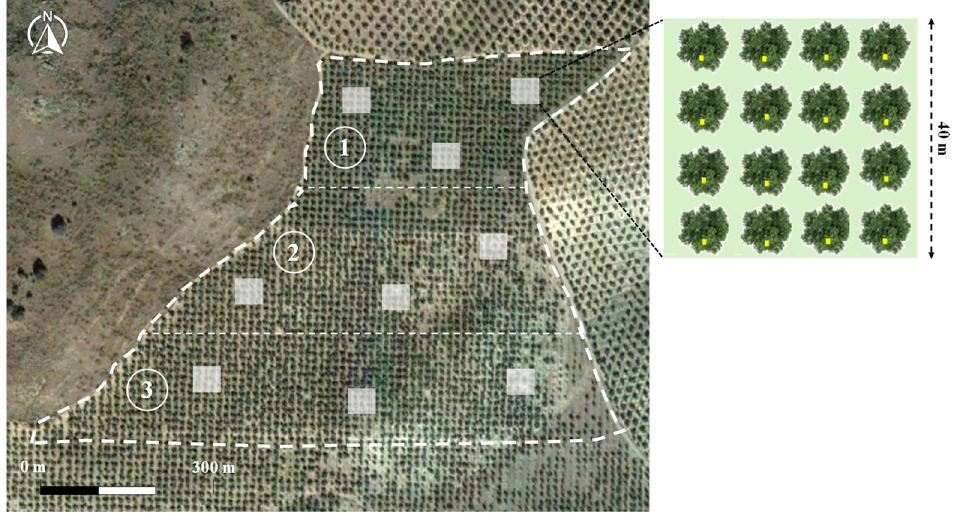
Figure 2. Distribution of the plots into the three organic olive grove blocks. Source: Own elaboration using the Google Earth Pro geographic information system.